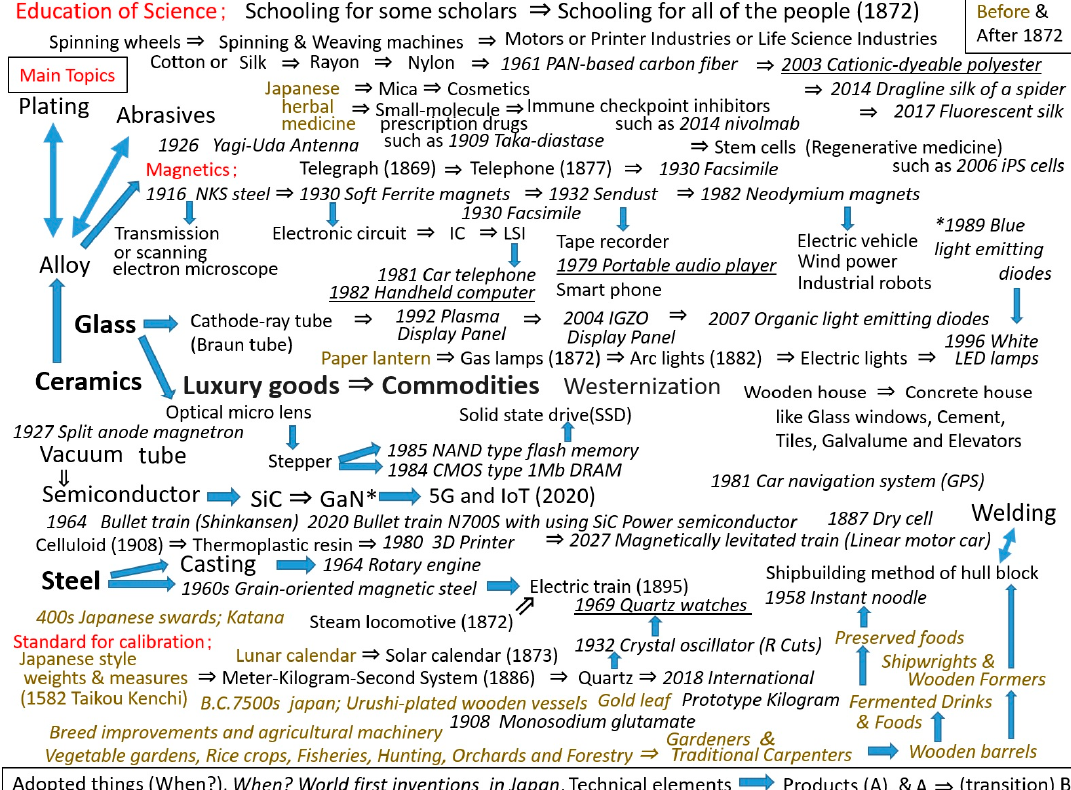
Figure 6. Technology adoption and inventions in Japan.